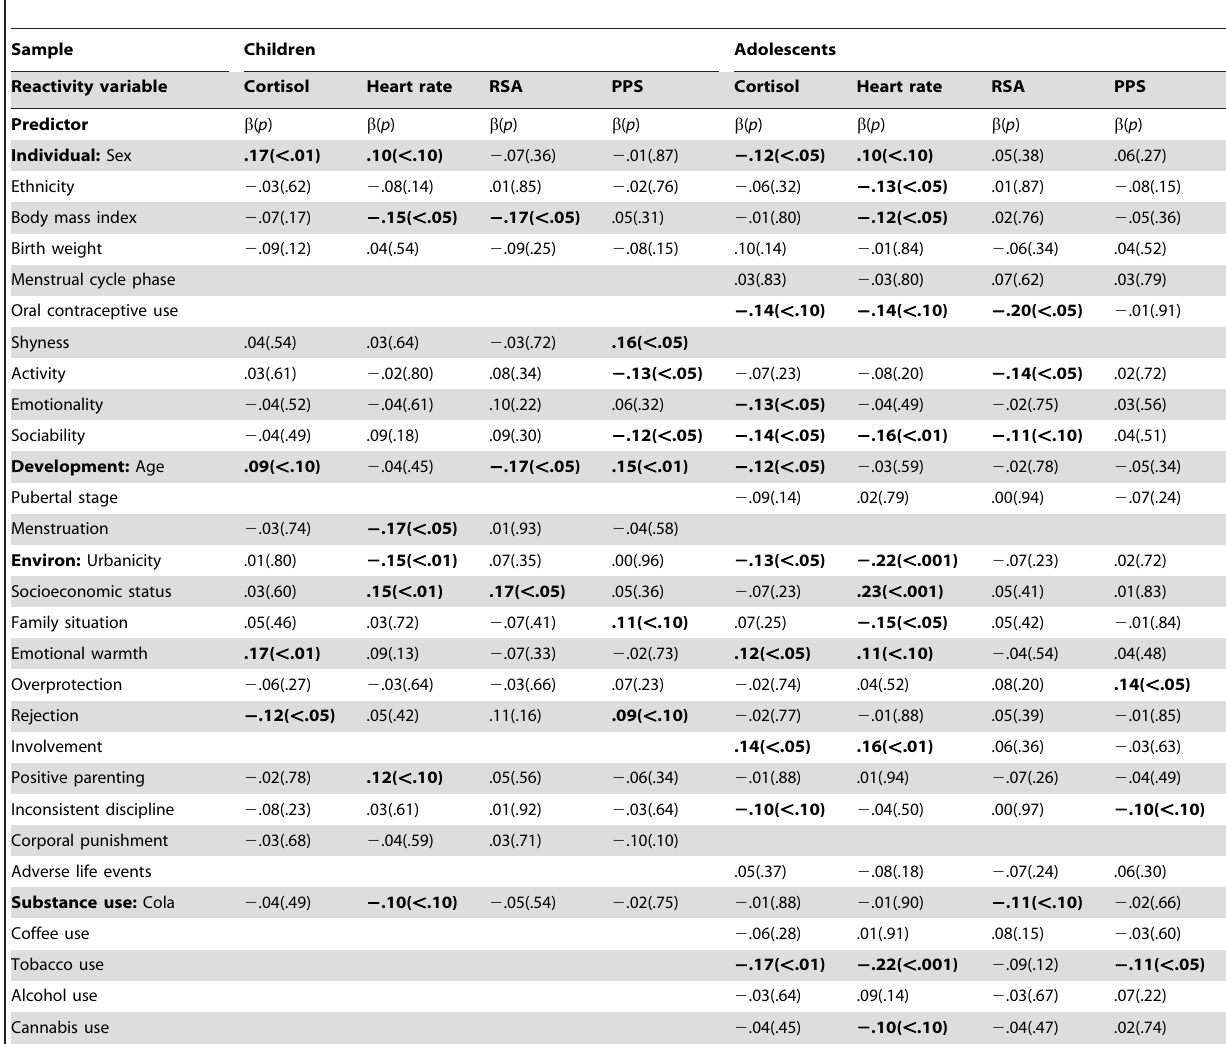
Table 3. Results of the linear regression models predicting each stress response in children and